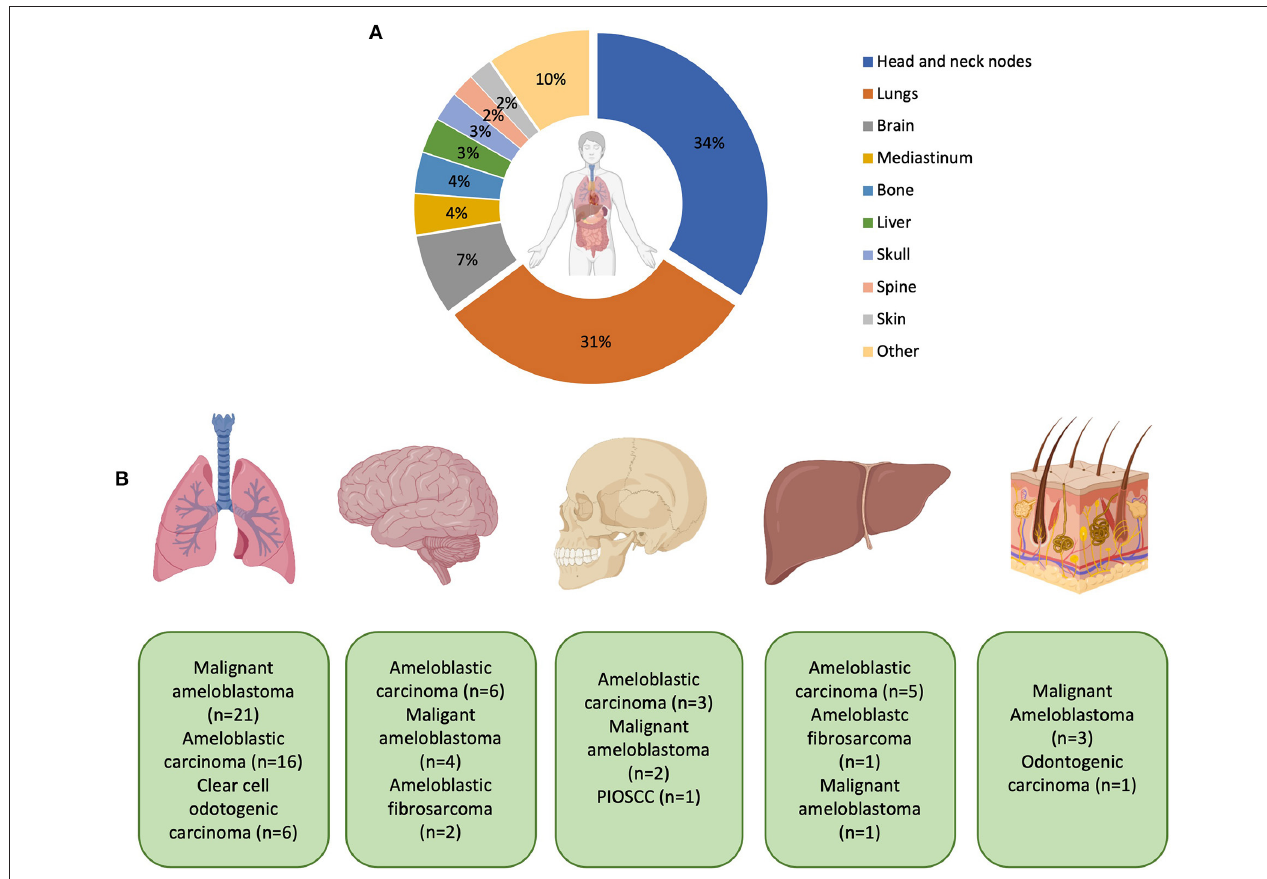
FIGURE 6 | (A) Representation of the most common sites of metastasis. Percentages are expressed to only reflect patients who have had metastases. Patients with no recorded metastasis are not included in this calculation. The “other” category includes the thyroid, kidneys, non-cervical lymph nodes, and cranial nerves (all 1.1%) and salivary glands, pharynx, orbit, larynx, intestines, heart, branchial plexus, carotid bifurcation, and unspecified distant metastasis (all 0.5% respectively). (B) Graphic representation of the most common MOTs metastasising to distant sites (from left to right: lungs, brain, skull, liver and skin–mediastinum was not included in the diagram). With metastasis to the lung, ameloblastic fibrosarcoma ( n = 2), squamous cell carcinoma ( n = 2), unspecified odontogenic biphasic malignant neoplasm ( n = 1), and unspecified odontogenic carcinoma ( n = 1) were also recorded but not shown in the diagram. With metastasis to the brain, clear cell odontogenic carcinoma and unspecified odontogenic carcinoma were both recorded (both n = 1) but also not shown in the diagram. Created with BioRender.com.